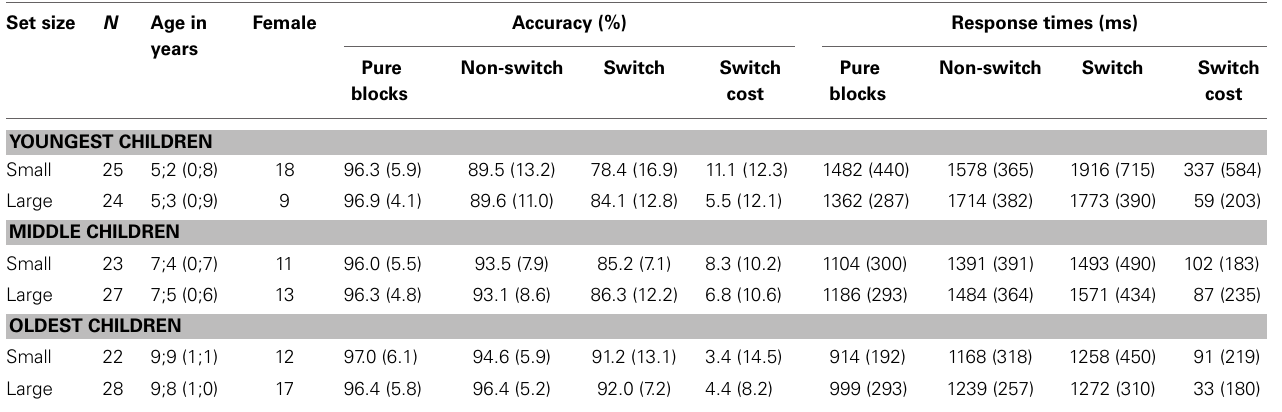
Table 1 | Mean accuracy rates and response times by trial type in Experiment